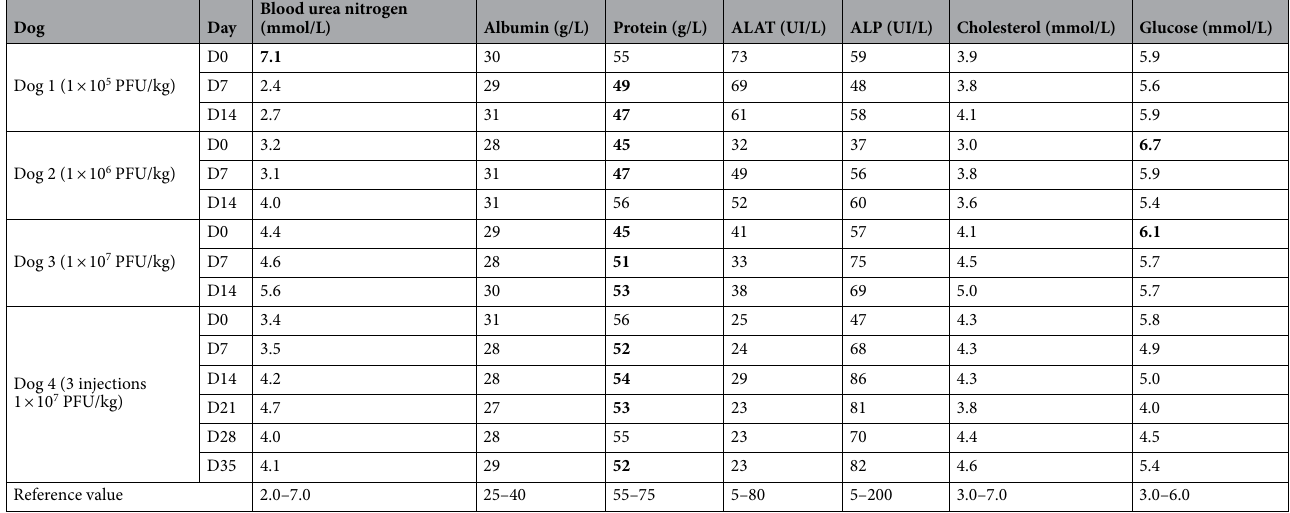
Table 1. Biochemical analyses of dogs after single and three intravenous injections of TG6002. Bold numbers refer to values that are outside the reference